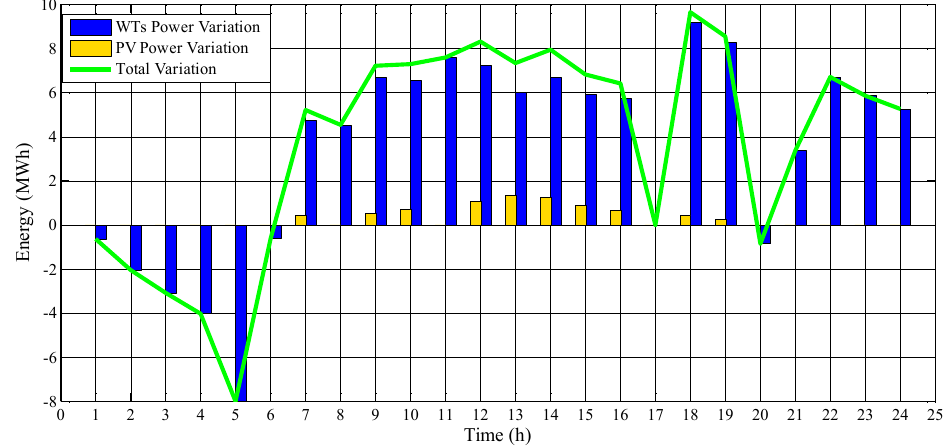
Figure 15. DSO’s traded energy in the RT markets for scenario 6 considering the competitive environment.